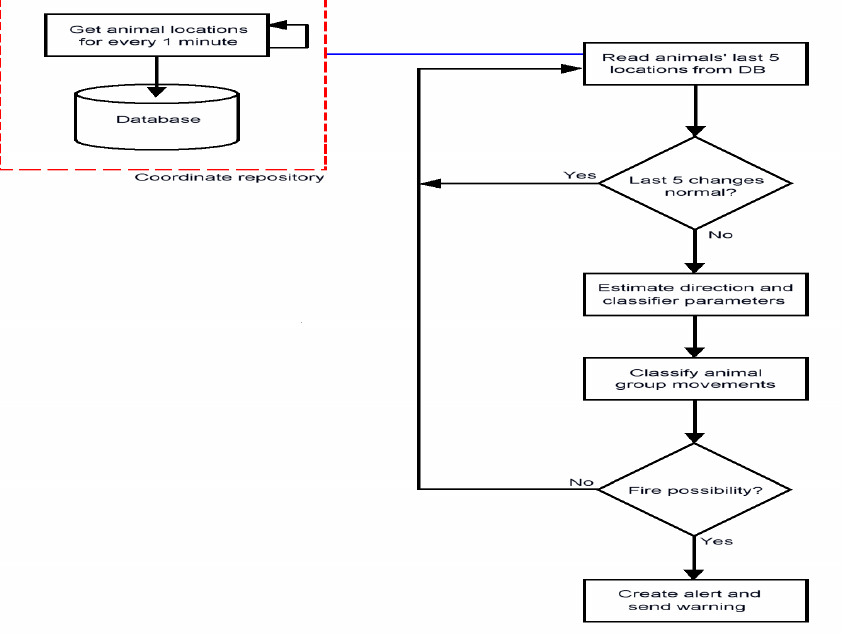
Figure 8. MBS actions classifier flowchart.